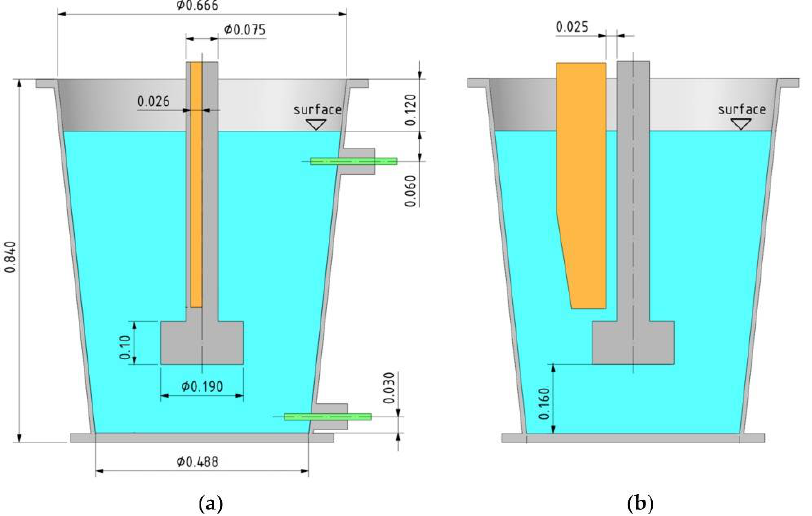
Figure 2. Basic dimensional data (m) of the physical model and individual components: ( a ) front view, ( b ) side view.